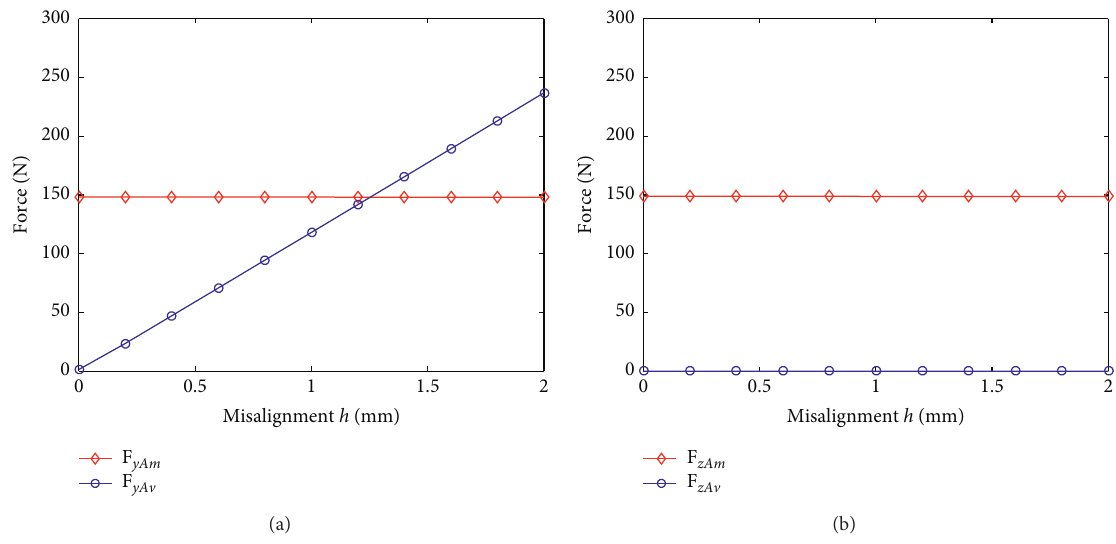
Figure 12: Reaction forces characteristic of misaligned support. (a) Forces in the y -direction (misalignment direction). (b) Forces in the z